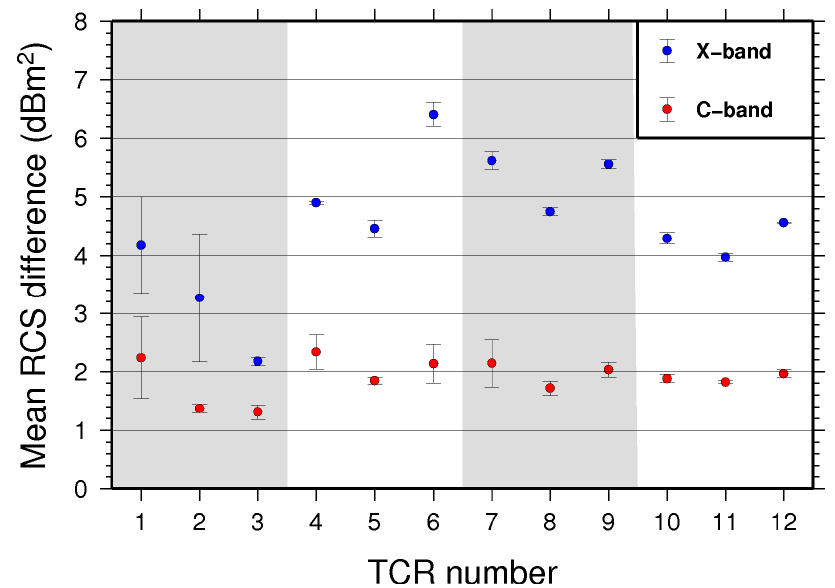
Figure 5. Mean RCS difference (theoretical minus measured) for TCR prototype designs measured at the ground radar reflection range. The mean for each frequency is calculated from four independent measurement combinations (HH/VV polarisation and azimuth/elevation sweep) with error bars indicating the standard 1-sigma error of these measurements. Grey polygons delineate the different type groups of corner reflector design indicated in Table 2. Modified from [36]. Table 2. Details of the 18 TCRs of six type groups deployed at Gunning. Misalignments of the TCR from the optimum boresight orientation for each SAR sensor were only applied for certain image acquisitions (see Table 3) during a secondary experiment described in the